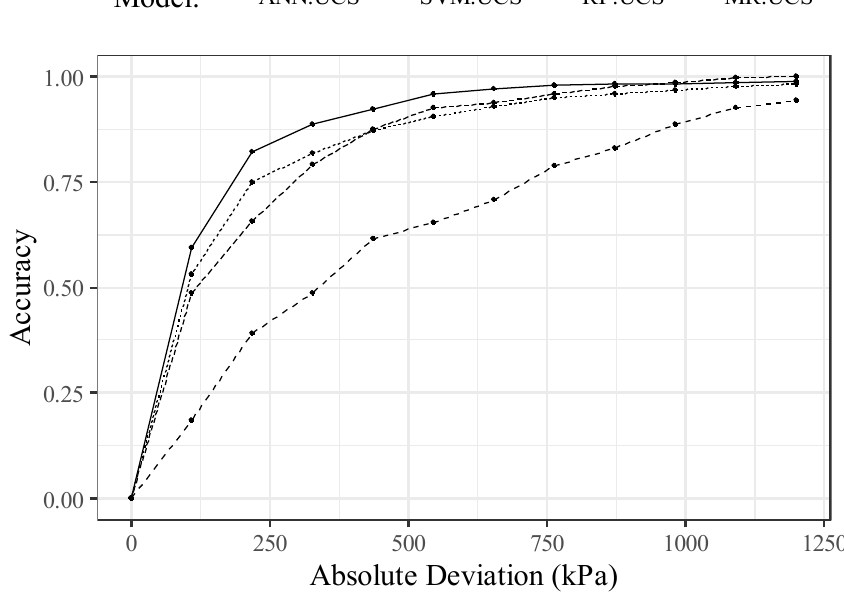
Figure 3. A comparison of ANN.UCS, SVM.UCS, RF.UCS and MR.UCS models performance in UCS prediction of soil–binder–water mixtures reinforced with fibers based on REC curves.